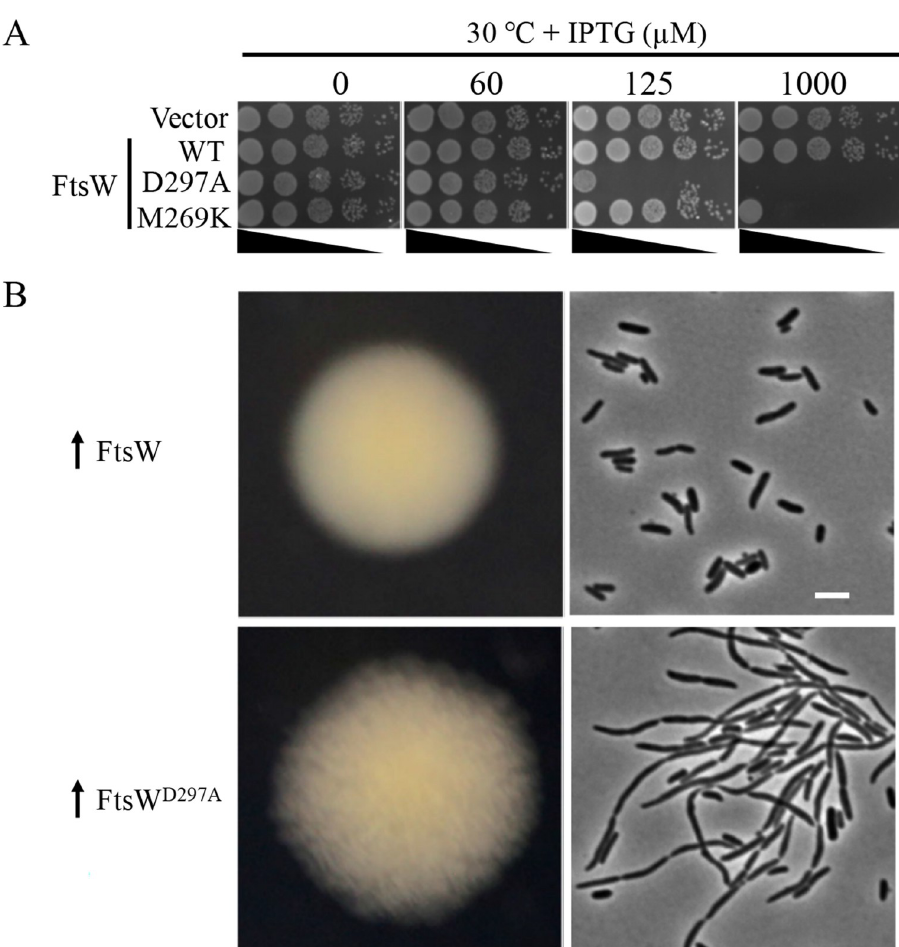
Fig 1. Modest overexpression of non-functional FtsW mutants are dominant-negative and produce wrinkled- colonies. (A). A spot test of the dominant-negative effect of inactive FtsW mutants. Plasmids pDSW208, pSEB429 (pDSW208, P 204 :: ftsW ) or its derivatives harboring either the putative catalytic mutation (D297A) or an activation defective mutation (M269K) were transformed into strain JS238 on LB plates with ampicillin and glucose. The next day, a single transformant of each resulting strain was resuspended in 1 ml of LB medium, serially diluted and 3 μ l of each dilution was spotted on LB plates with antibiotics, with or without increasing concentrations of IPTG. Plates were incubated at 30˚C overnight and photographed. (B) Colony and cell morphology of E . coli cells modestly overexpressing FtsW D297A . Plasmids expressing wild type FtsW or FtsW D297A were transformed into JS238 as described in (A), but plated on LB plates with 30 μ M IPTG. Cells within the colonies were picked and examined. Scale bar, 3 μ